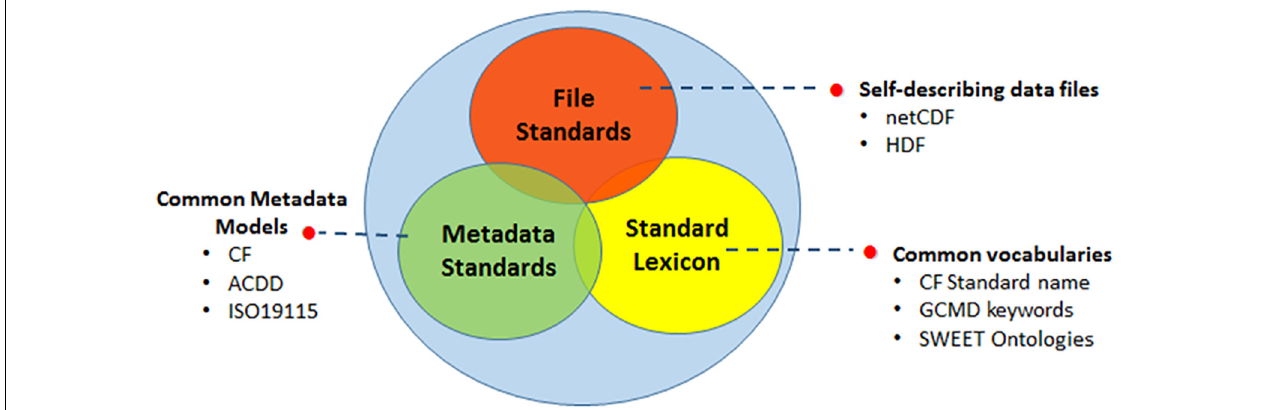
FIGURE 2 | The three main categories of data interoperability standards: file standards, metadata standards and standard lexicon, allow integration of data in a range of software applications and Web services including data distribution, processing, modeling and visualization capabilities, thus enabling more widespread usage of